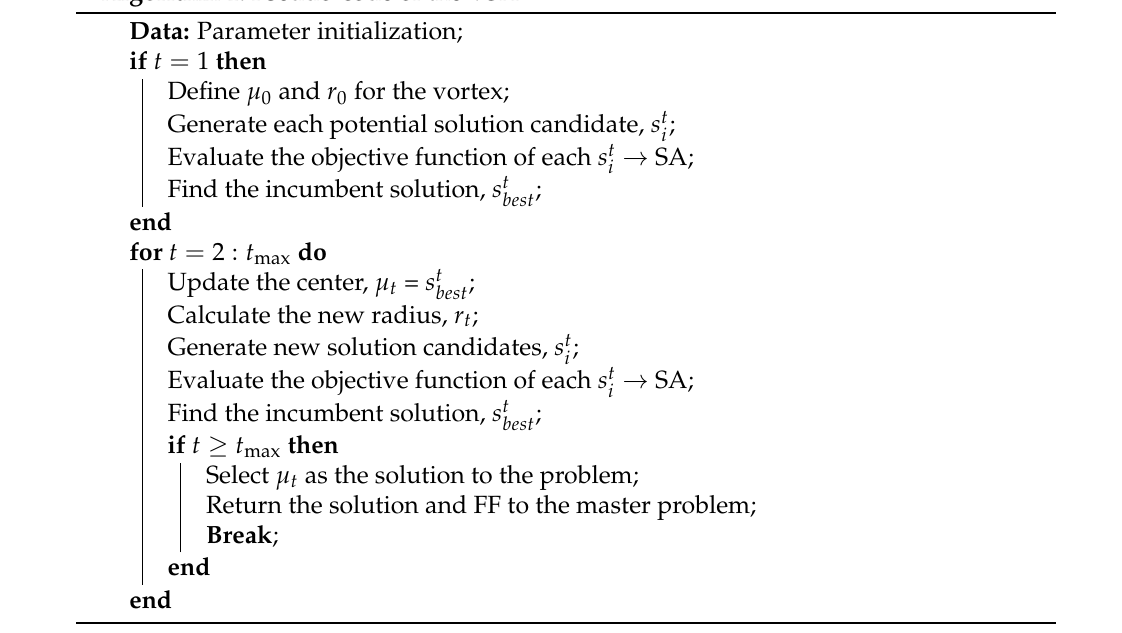
Algorithm 1: Pseudo-code of the